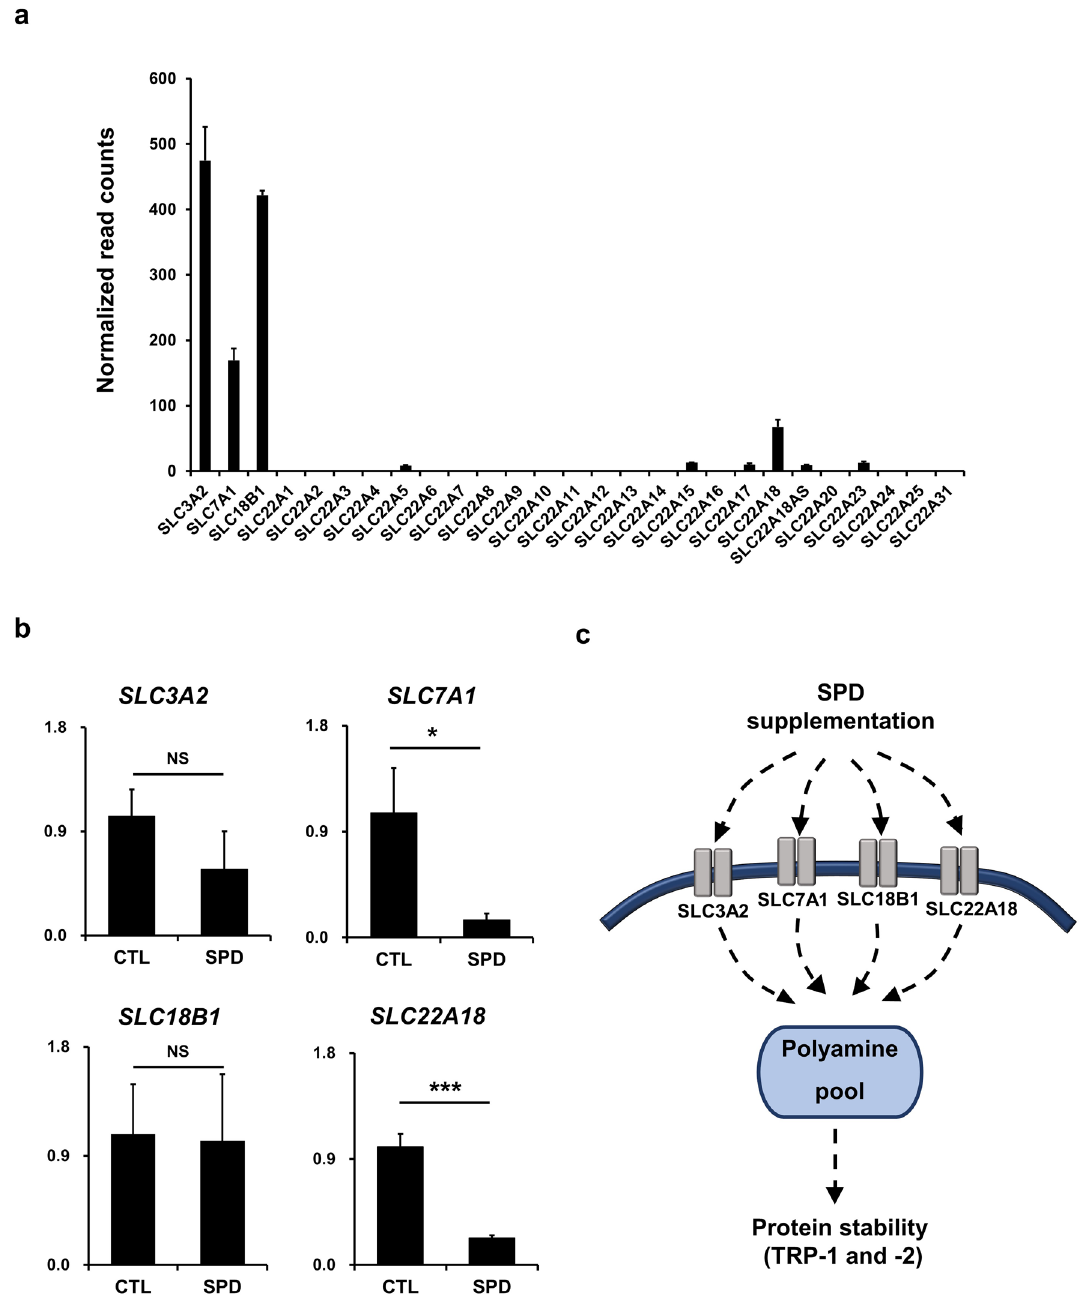
Figure 4. Identification of putative SPD transporters in primary human melanocytes. ( a ) RNA-sequencing analysis of 1 µg of total RNA of primary melanocytes representing the expression levels of solute carrier (SLC) family transporters. ( b ) mRNA expression levels of primary melanocytes after treatment with 1 μM of SPD for 10 days. The data represent the results of three independent experiments. CTL: control, NS: non- significant, *P < 0.05 , **P < 0.01 , *** P < 0.005. ( c ) Schematic representation of the effects of SPD treatment in the improvement of the stabilities of TRP-1 and TRP-2 through the increase of the cellular polyamine